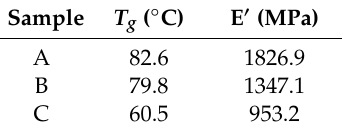
Table 5. E ′ and T g of the UV-cured polymer and hybrid films obtained from DMA. Sample T g (°C) E ′ (MPa)